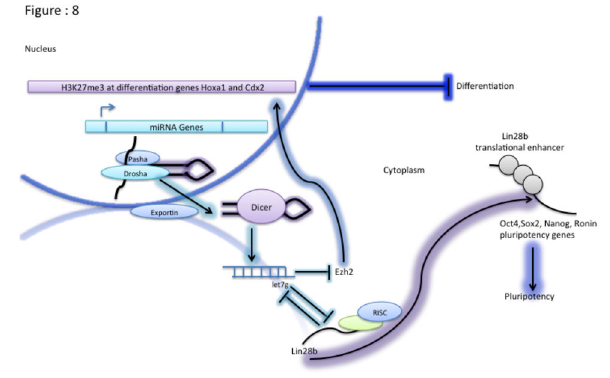
Figure 8. Putative model explaining Dicer mediated regulation of mES cell differentiation. When ES cells